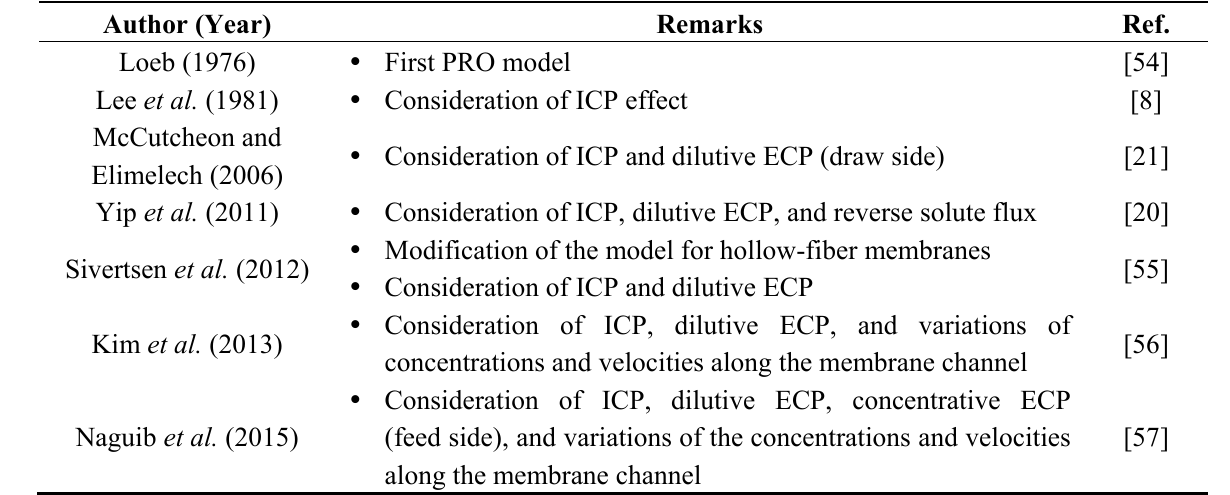
Table 3. PRO model